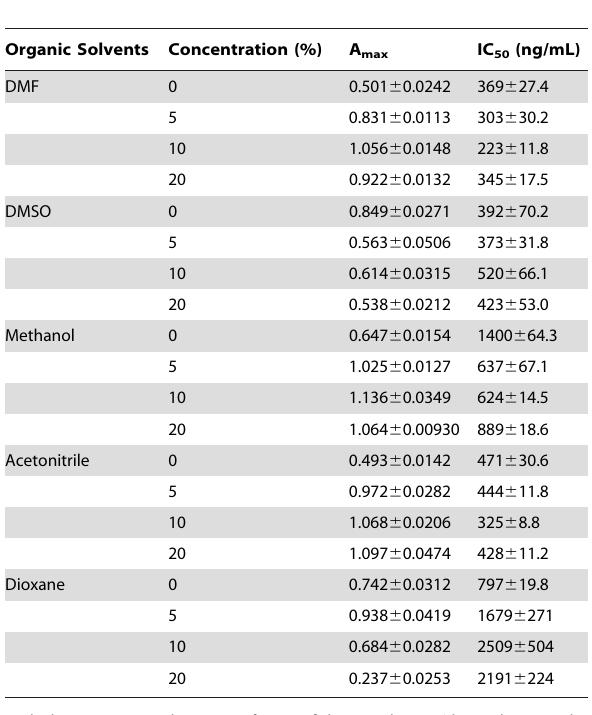
Table 3. Influence of organic solvents in assay buffer on parameters of